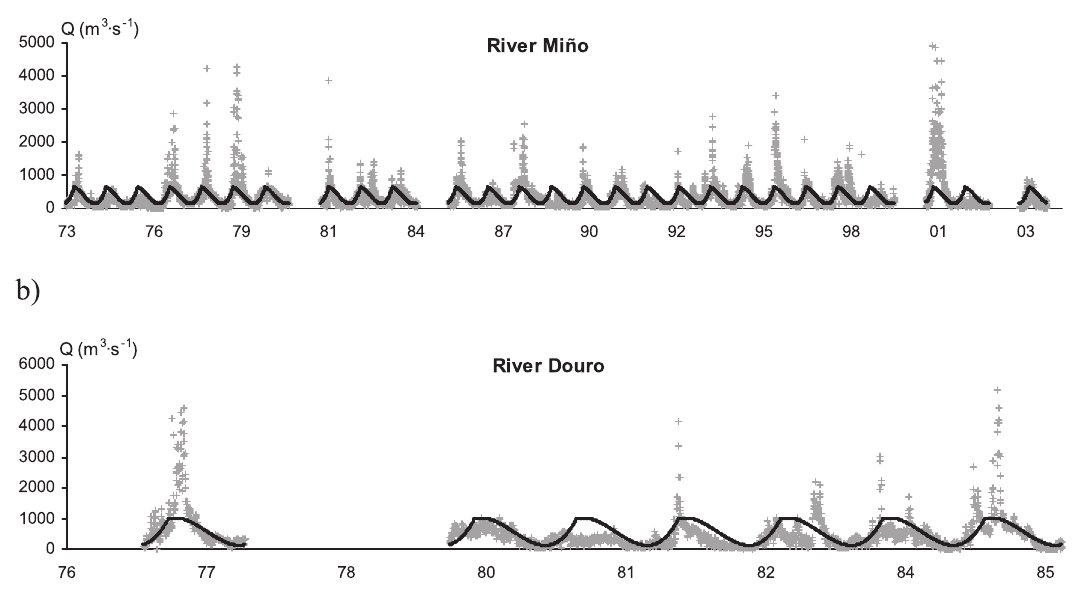
Fig . 4. – Plots showing the high inter-annual river discharge variability and the error-fitting with climatological values. River discharge data corrected as explained in Material and Methods (grey dots) is compared to the estimated climatological value from the Results section (black line). The complete available time series is plotted in the River Miño (a); nevertheless, only data estimated from the Rio Mau station are plot- ted in the River Douro (b) to avoid a very long time